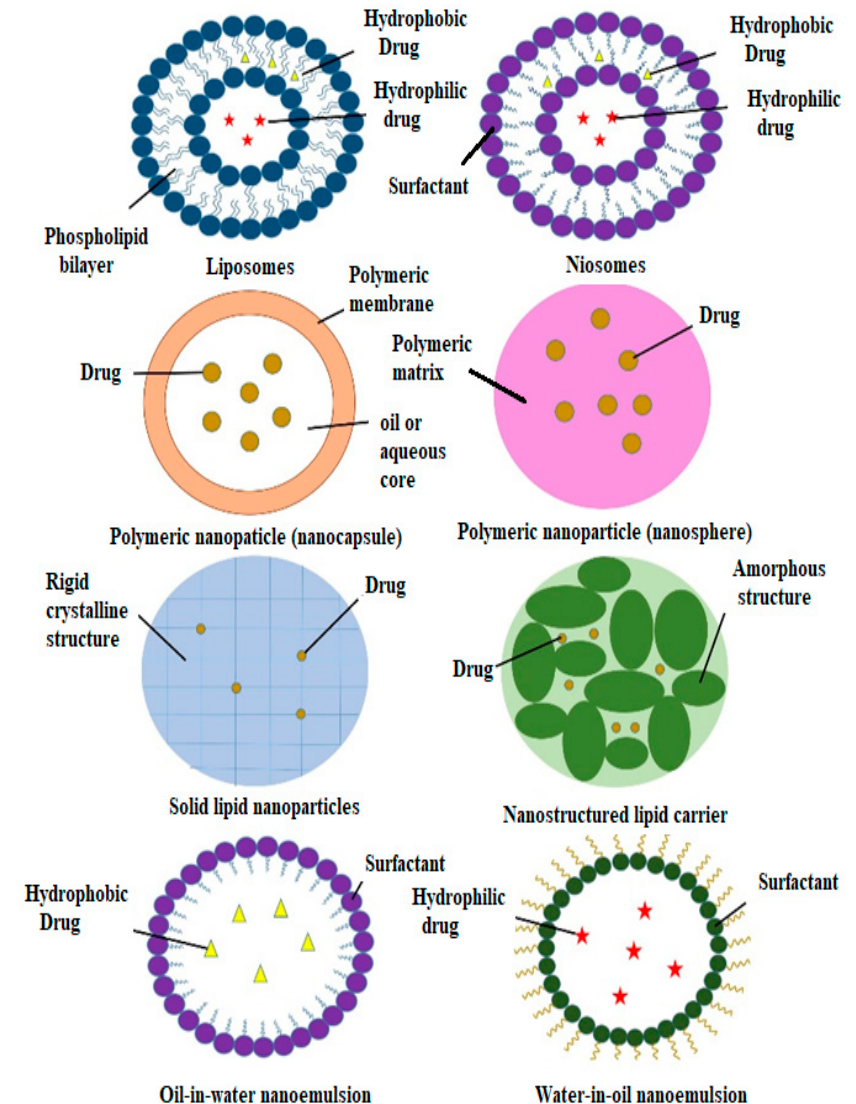
Figure 3. Different types of nanocarriers for antidiabetic agents.